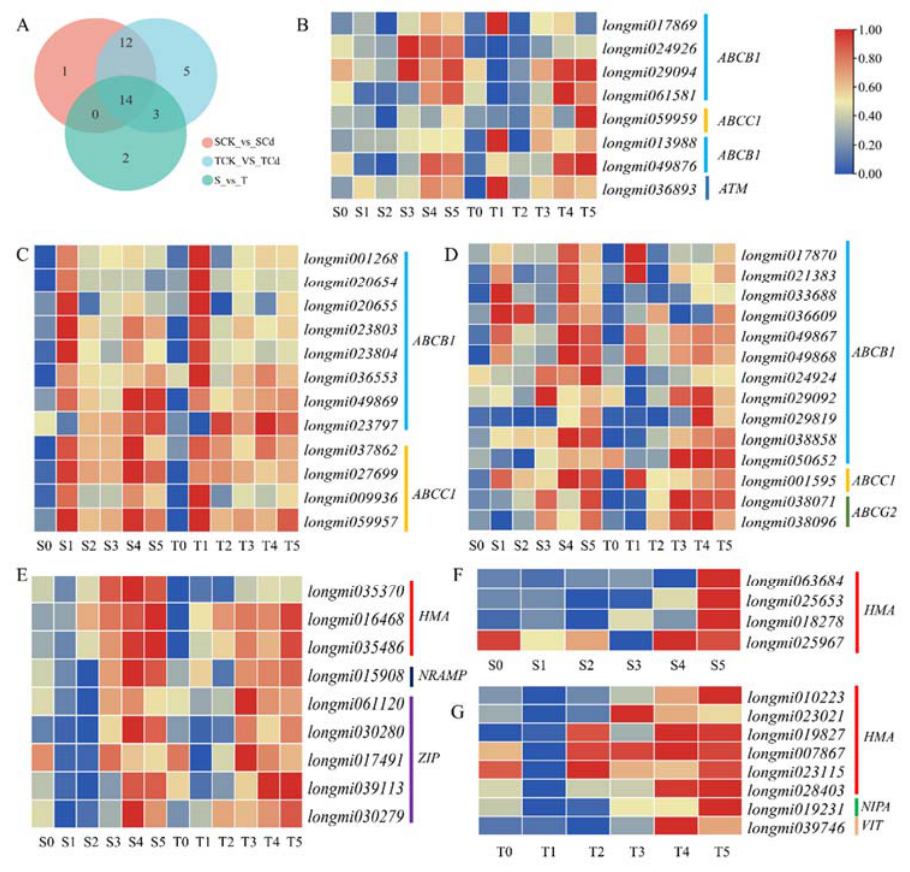
Figure 8. Venn diagram of differentially expressed genes (DEGs) involved in ABC transport pathway ( A ), expression pattern heatmaps of ( B ) DEGs induced by Cd stress in the Cd-tolerant variety, ( C ) DEGs induced by Cd stress in the two varieties, ( D ) DEGs induced by Cd stress and differently expressed in the two varieties, ( E ) DEGs induced by Cd stress and differently expressed in the two varieties, ( F ) DEGs induced by Cd stress in the Cd-sensitive variety, and ( G ) DEGs induced by Cd stress in Cd-tolerant variety. SCK_vs._SCd, TCK_vs._TCd, and S_vs._T represent DEGs between control and Cd treatments in the Cd-sensitive variety, between control and Cd treatments in the Cd-tolerant variety, and between the two varieties,